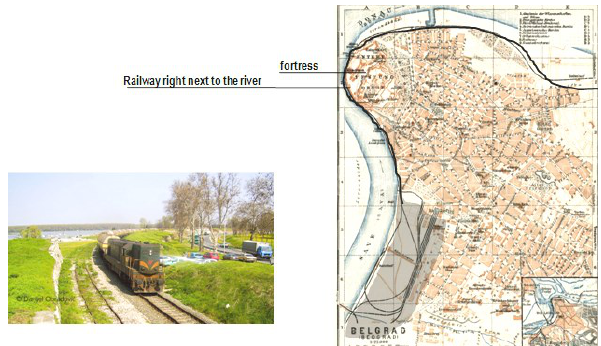
Figure 4. The railway next to river separating the Old Belgrade from its waterfront (Plan of Belgrade of 1929, author marked the railway https://www.discusmedia.com/maps/serbian_town_plans/45